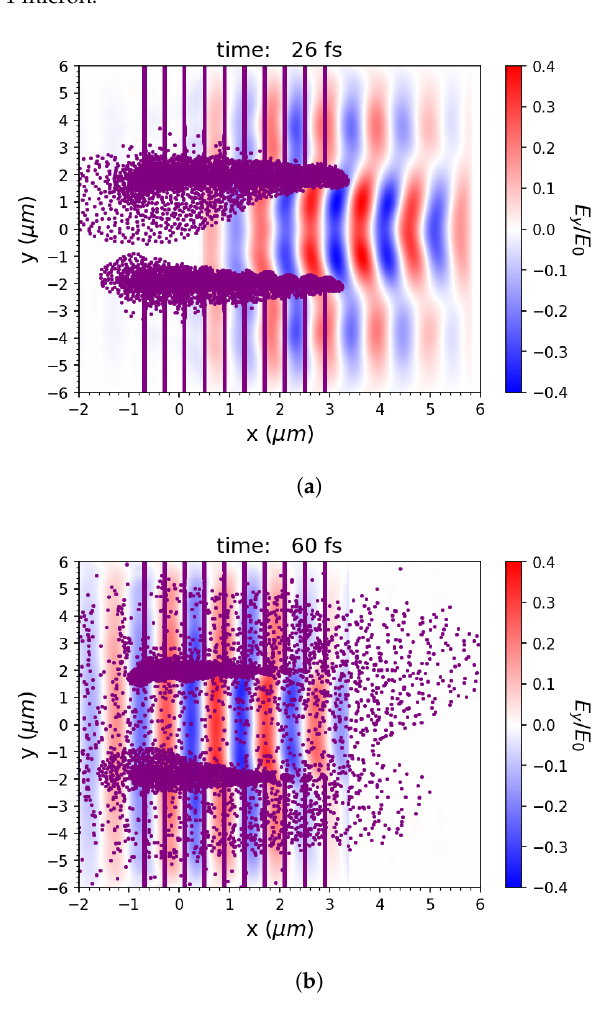
Figure 8. Example of simulation results with first laser extracting electrons from the CNTs ( a ) and a second pulse accelerating the extracted electrons ( b ). The purple dots indicate the locations of individual electrons, and the colormap indicates the strength of the laser field. The laser field is normalized to the nominal peak amplitude E 0 ≈ 1.6 × 10 12